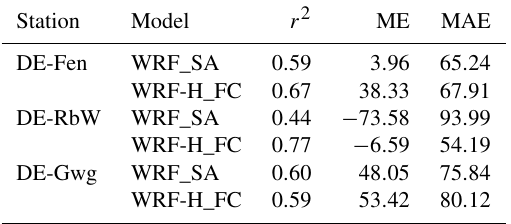
Table 4. Performance measures for latent-heat flux (Wm − 2 ) with simulations vs. flux-tower observations for June to October 2016. Station